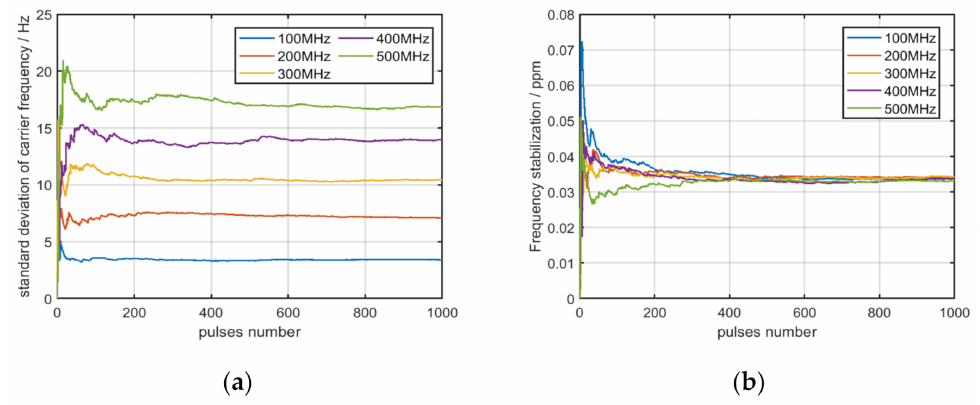
Figure 4. ( a ) The value of standard deviation at five different carrier frequencies; ( b ) the value of frequency stabilization at five different carrier